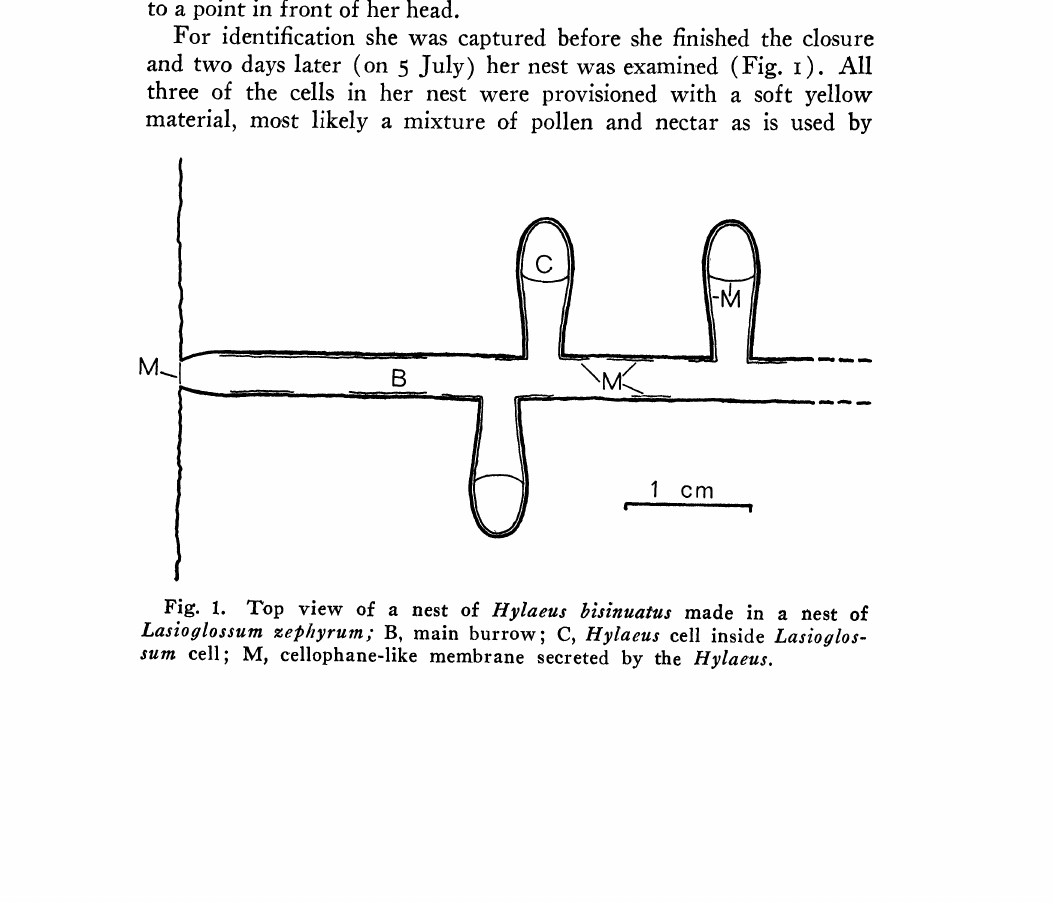
Fig. 1. Top view o a nest of Hylaeus bisinuatus made in a nest of Lasioglossum zelhyrum; B, main burrow; C, Hylaeus cell inside Lasioglos- sum cell; M, cellophane-like membrane secreted by the